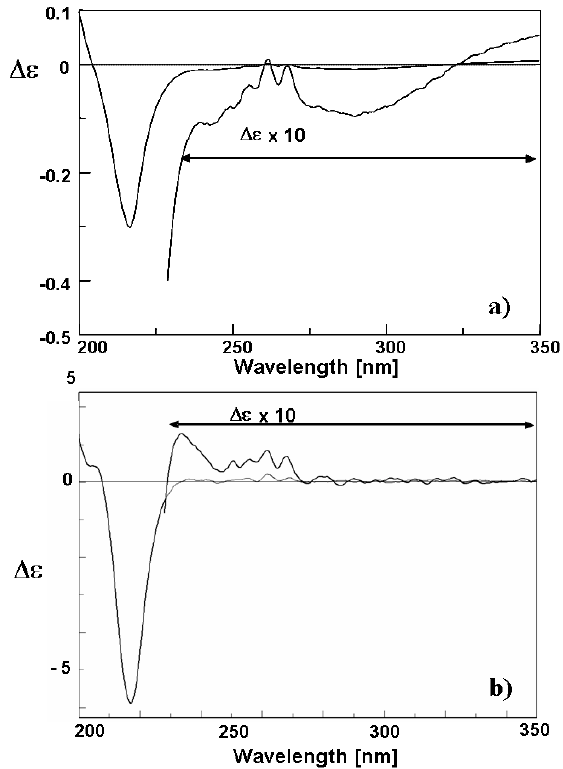
Figure 5. ( a ) CD spectrum of a n-heptane solution of: ( − )( S ) S ( S ) C -Et(PhBu)SO, ( III ) with de 18%; ( b ) CD spectrum of a n-heptane solution of: ( − )( R ) S ( S ) C -Et(PhBu)SO ( IV ) with de 31% obtained by decomposition of the complex of Reaction (3).